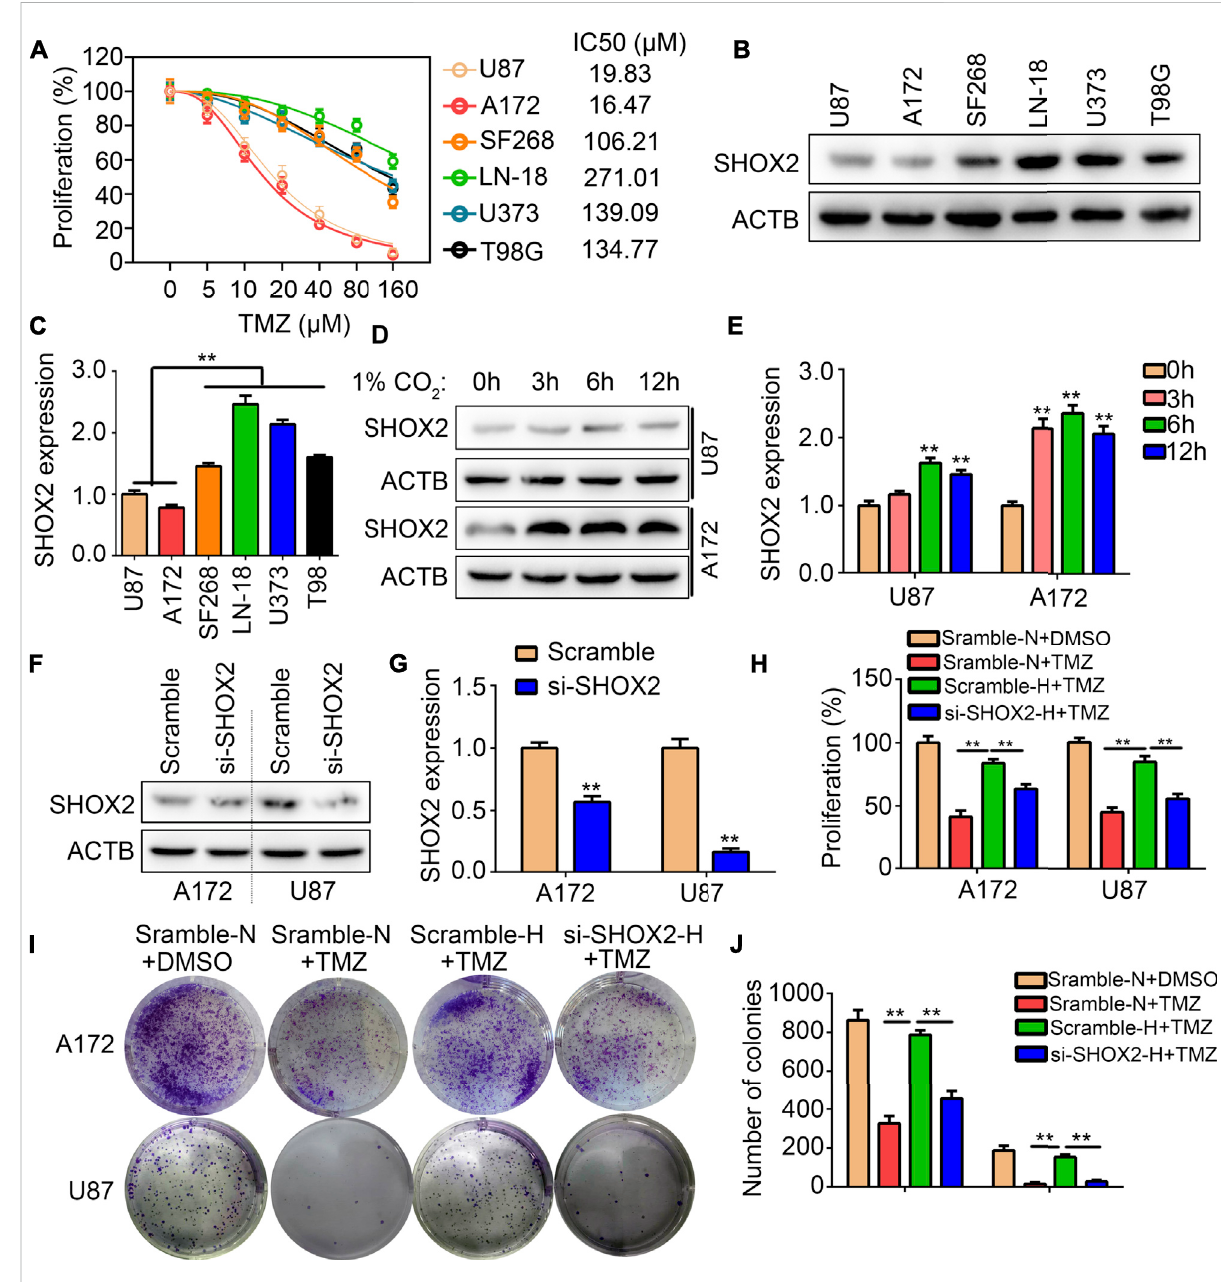
FIGURE 9 SHOX2linkedtohypoxiaandTMZ-resistance. (A) CCK-8wasusedtodeterminetheIC50ofTMZin48 hforU87,A172,SF268, LN-18,U373and T98cells. (B,C) WesternblotwasusedtodeterminetheexpressionofSHOX2inU87,A172,SF268, LN-18,U373andT98cells. (D,E) Westernblotwas used to determine the expression of SHOX2 in U87 and A172 cells under hypoxia for 0, 3, 6 and 12 h (F,G) Western blotting was to determine the expression of SHOX2 in U87 and A172 after treatment with siRNAs. (H) CCK-8 assays were used to determine the effects of SHOX2 on TMZ- resistance underhypoxia. (I,J) ColonyformationassayswereusedtodeterminetheeffectsofSHOX2onTMZ-resistanceunderhypoxia.**, p <